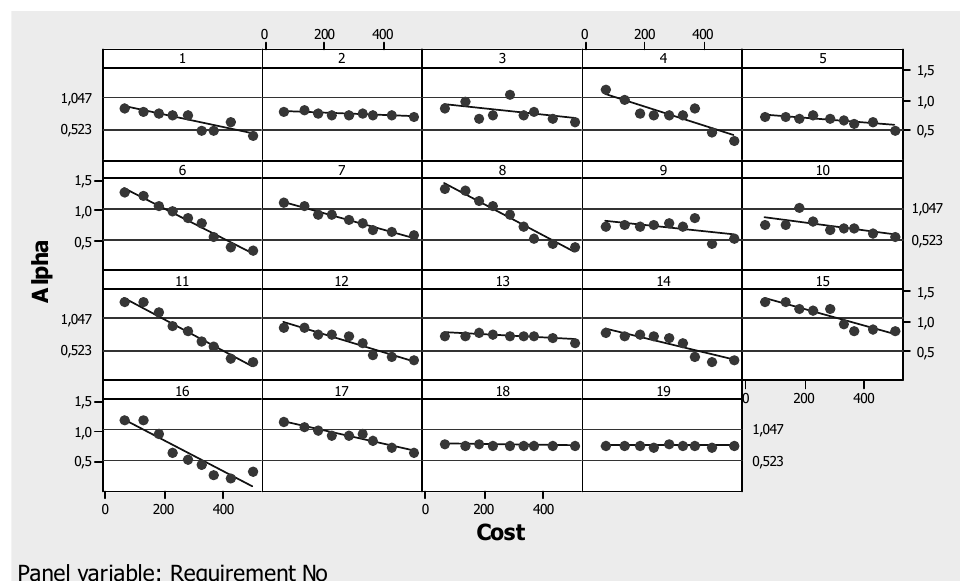
Figure 4 – Scatter plot of Alpha vs Cost